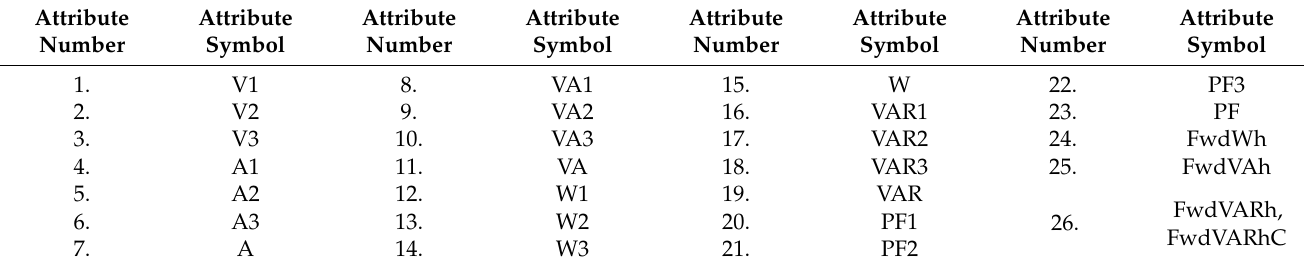
Table 2. Attributes of the